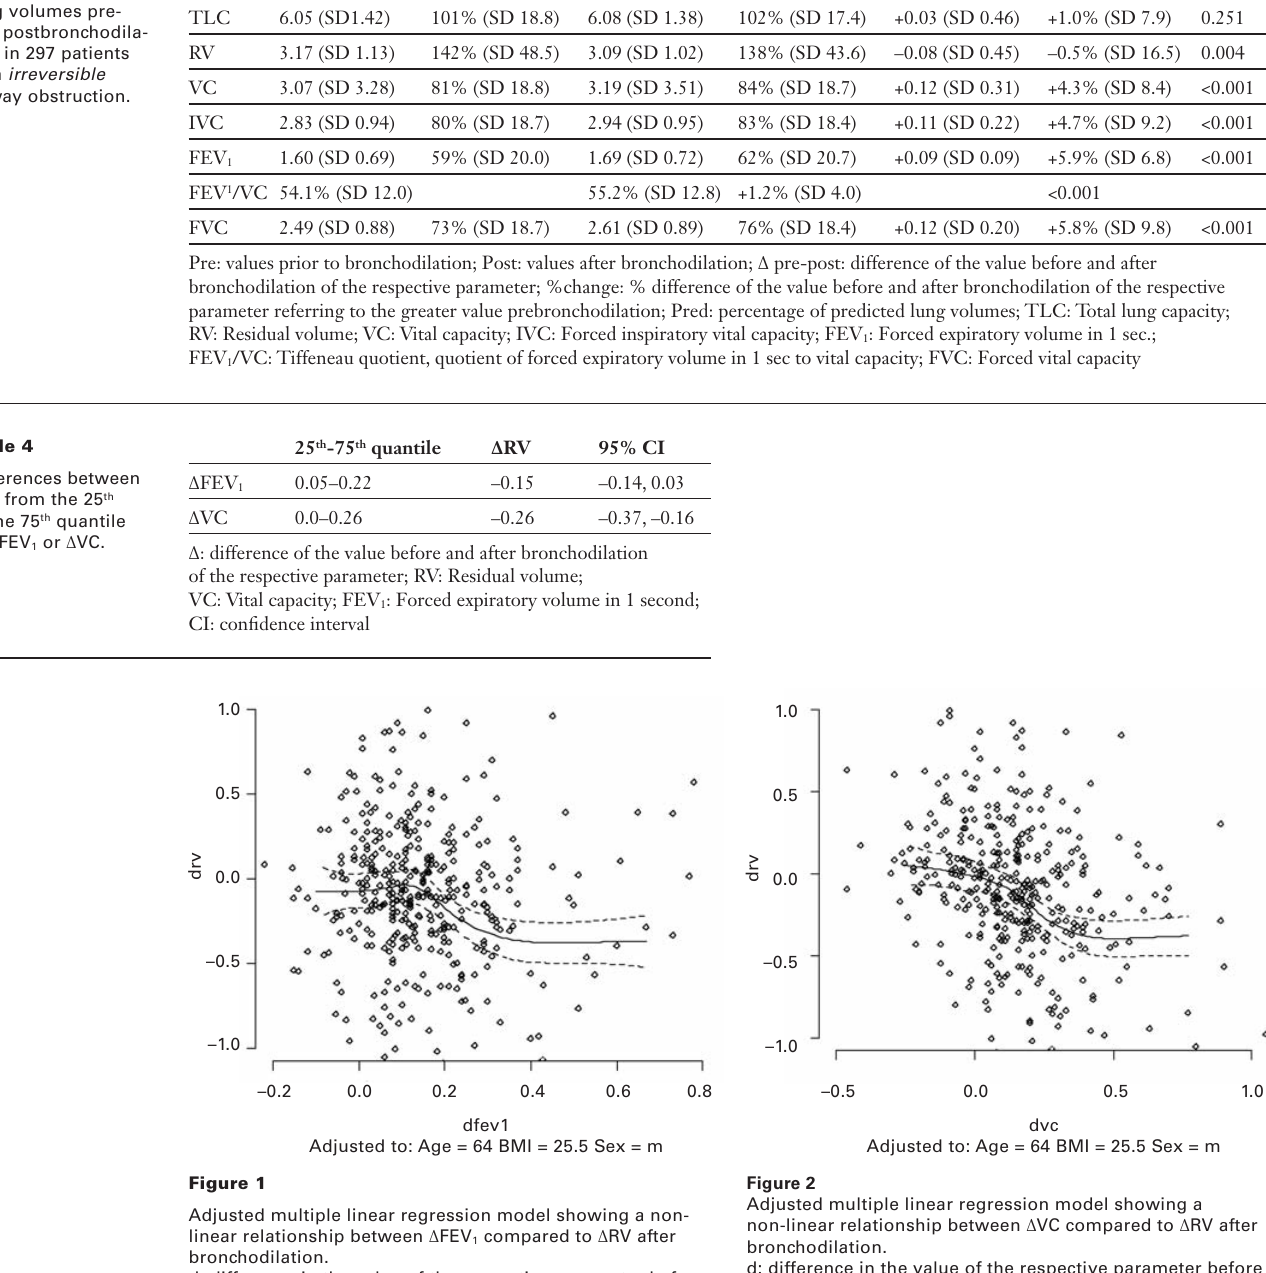
Static and dynamic lung volumes pre- and postbronchodila- tion in 297 patients with irreversible airway obstruction.